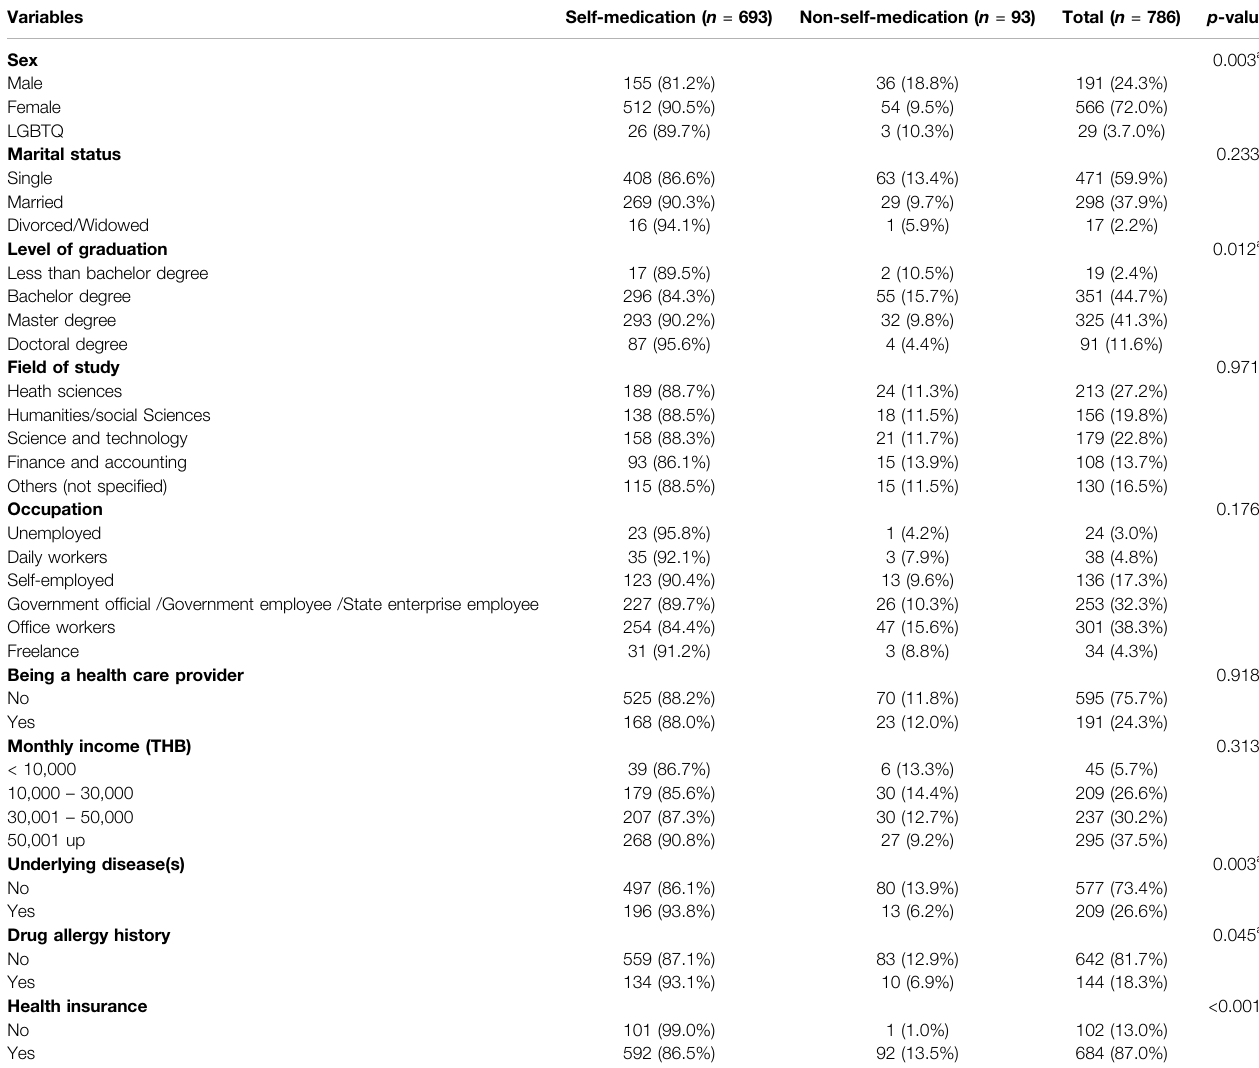
TABLE 1 | Sociodemographic characteristics of respondents by self-medication ( n (cid:1) 786).